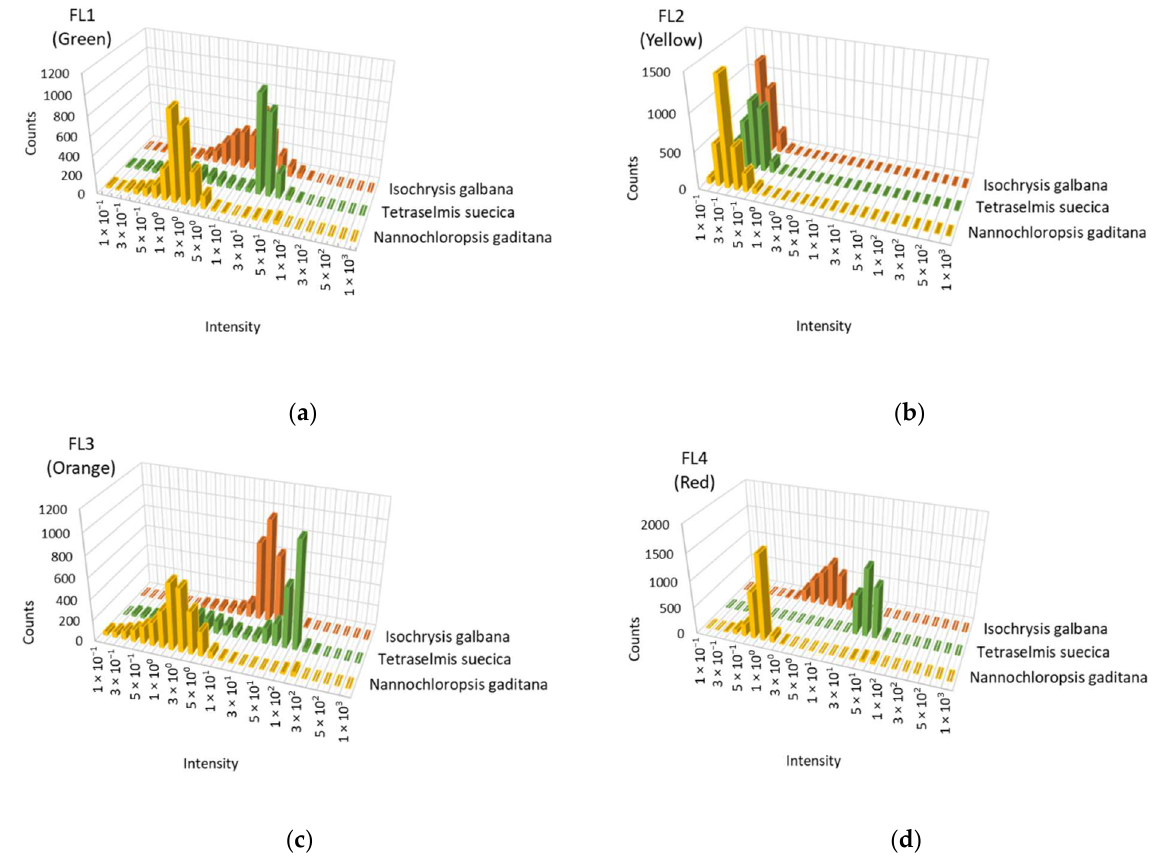
Figure 10. Size as a function of complexity for each of the phytoplankton species, obtained by flow cytometry: ( a ) FL1-525 nm (green); ( b ) FL2-575 nm (yellow); ( c ) FL3–620 nm (orange); ( d ) FL4–675 nm (red).